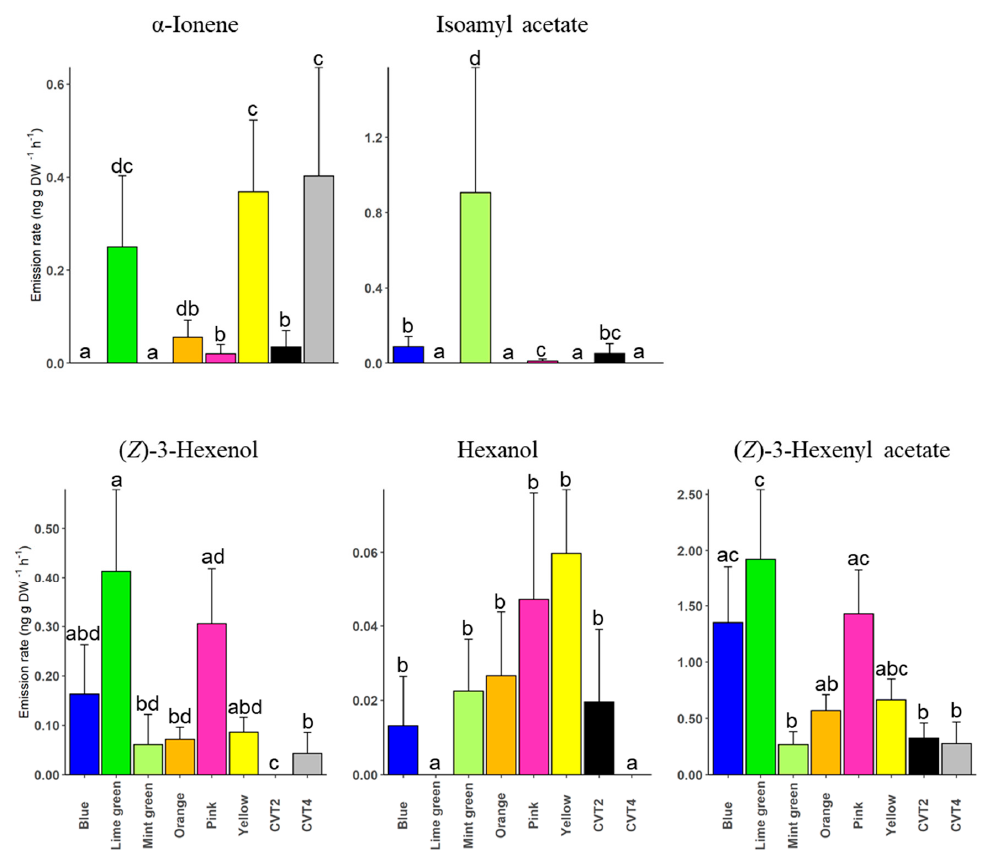
Figure 4. Comparison of selected green leaf volatiles and other compounds ( α -ionene and isoamyl acetate) between genotypes ( n = 5). Compounds were selected based on their VIP coefficients ( ≥ 1). A set of level contrasts was constructed using the “relevel” function in R. Bars show mean ± SE emissions, and different letters indicate significant differences between genotypes. The emission rates of selected sesquiterpenes also differed significantly between ma- nuka genotypes. For instance, the yellow clone emitted a significantly high amount of (E)- α -bergamotene compared to blue (t = − 7.95, p < 0.001), lime green (t = − 3.54, p = 0.001), mint green (t = − 7.95, p < 0.001), orange (t = − 3.30, p = 0.002), pink (t = − 3.26, p = 0.003), CVT2 (t = − 7.95, p < 0.001), and CVT4 (t = − 7.95, p < 0.001). A significant amount of isoledene, ylan- gene, γ -cadinene, and β -elemene was also released by the yellow clone (Figure 6, Supple- mentary Table S2). The blue clone also emitted a higher amount of isoledene, ylangene, α -amorphene, and β -selinene than the mint green clone and the two cultivars (Figure 6, Supplementary Table S5).